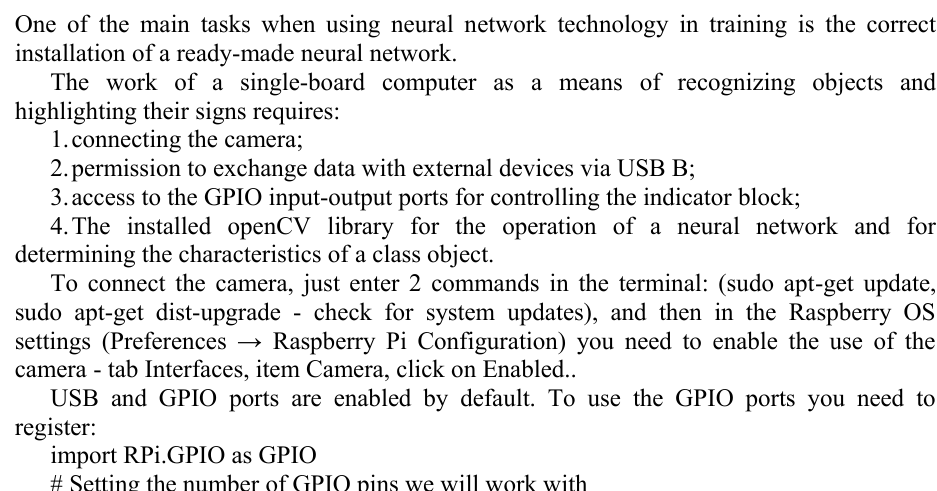
Fig. 4. Experimental verification of the neural network YOLO v3 - tiny on the Raspberry Pi 3B +. 6 Configuring Raspberry Pi to work with TVS